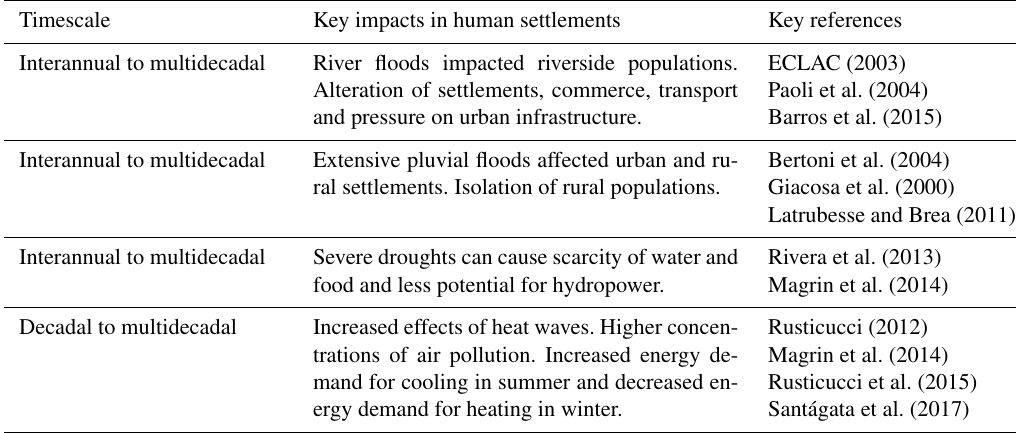
Table 5. Impacts of hydroclimate variability and its extremes in human settlements. The first column shows the main timescale of variability affecting the study sector. Key impacts in human